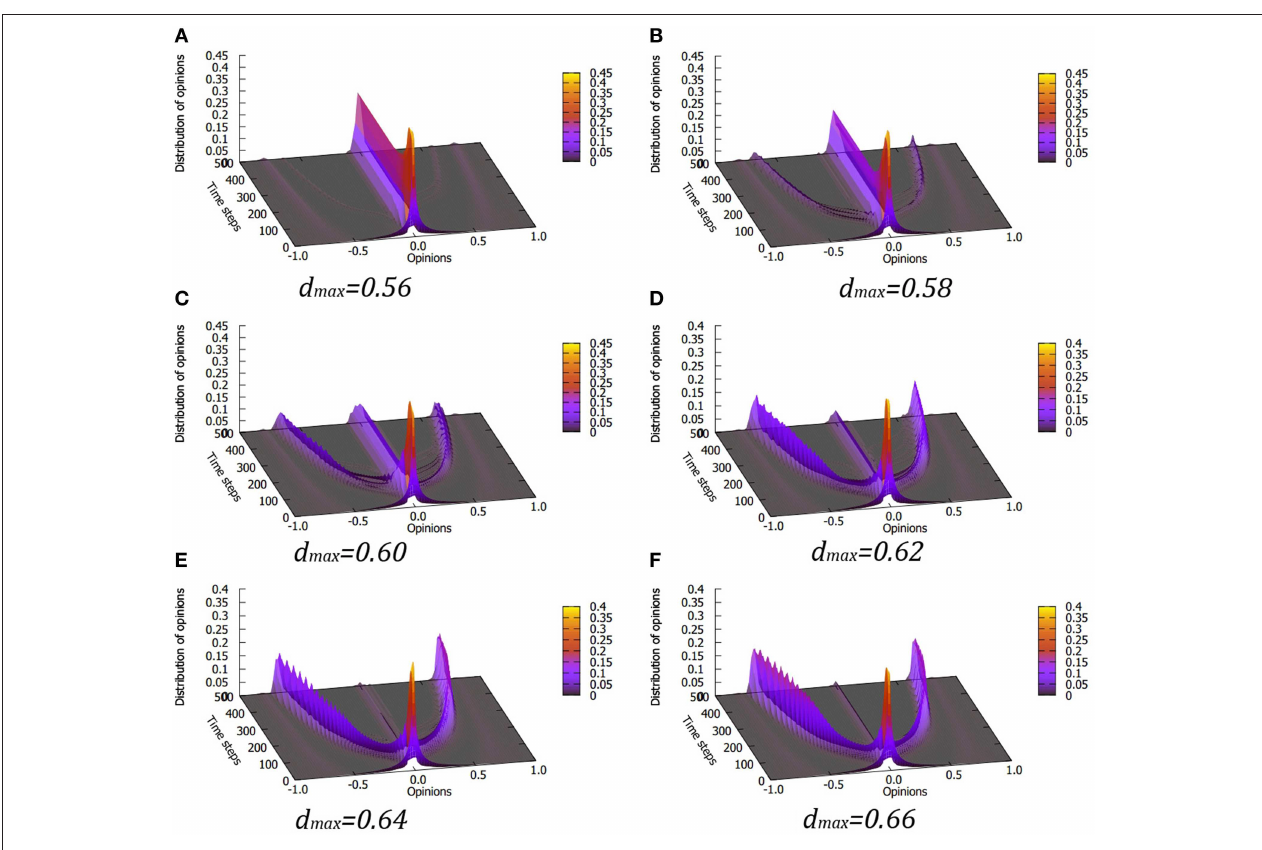
groups occurs. Note much larger values of the tolerance d max , for which the transition from moderate final state to extremism occurs, than in the previous simulations. However, this should be compared to the fact that available opinion space is twice as large. Panels (A–F) correspond to d max values of 0.56, 0.58, 0.60, 0.62, 0.64 and 0.66,